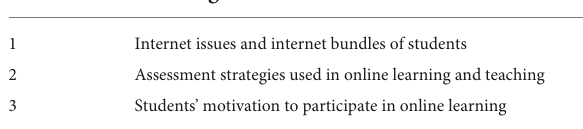
TABLE 4 Challenges by students in online English literature courses that were planned using both the ADDIE and UDL models.